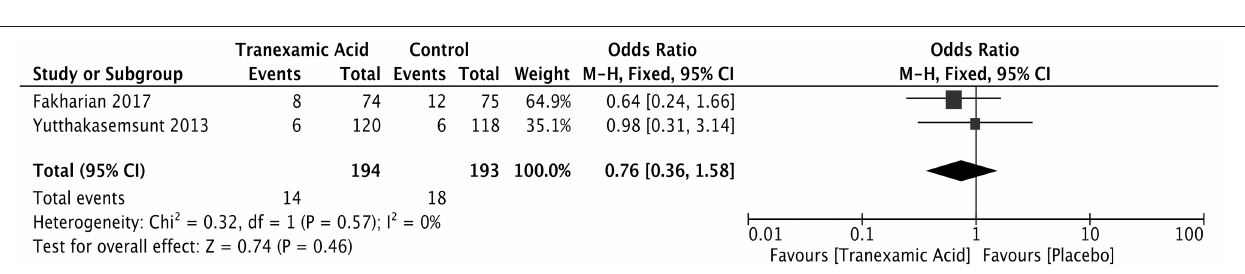
FIGURE 5 | Forest plot of the comparison between tranexamic acid and placebo treatments for the poor outcome.